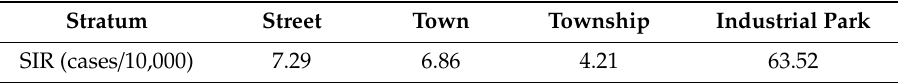
Table 3. SIR of lung cancer according to the administrative unit type stratum.